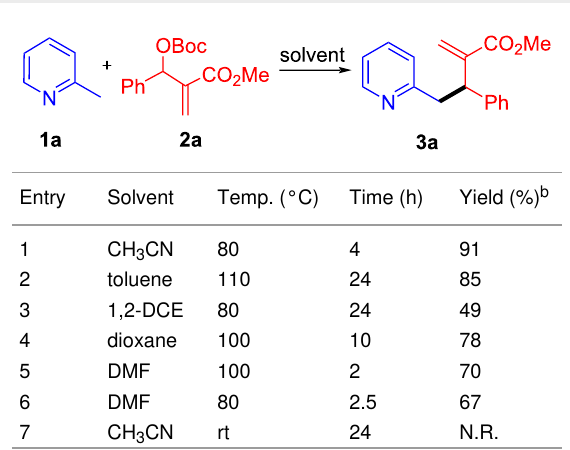
Table 1: Optimization of the reaction conditions for the allylic alkyl- ation of 1a .